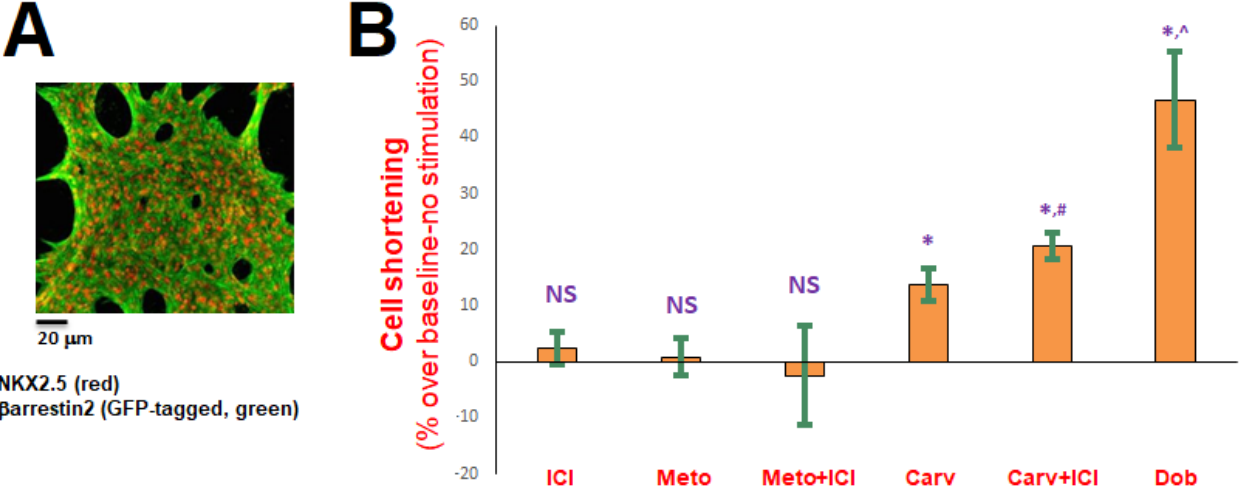
Figure 4. Cell shortening response of β arrestin2-overexpressing hIPSC-CMs. ( A ) Co-immunofluorescence performed on culture day 16 (48 h post-adenoviral infection) for NKX2.5 (cardiac myocyte marker, red) and for GFP (green) to confirm β arrestin2 overexpression (the adenovirus encoding for β arrestin2 also encoded for GFP, see Section 4.2 for details). ( B ) ICI: 10 µ M ICI 118,551; Meto: 1 µ M metoprolol; Carv: 1 µ M carvedilol; Dob: 1 µ M dobutamine. * , p < 0.05, vs. baseline (0.1% DMSO); # , p < 0.05, vs. Carv alone; ˆ, p < 0.05, vs. any other treatment; NS: Not significant vs. basal (0.1% DMSO) at p = 0.05; n = 3 independent measurements in 6–8 different myocytes per drug tested.